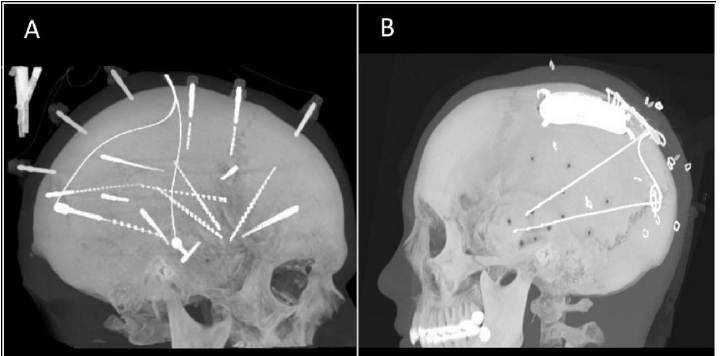
Figure 1. Computed tomography (CT) reconstruction images of patients after implantation of ( A ) sEEG electrodes and ( B ) RNS system.